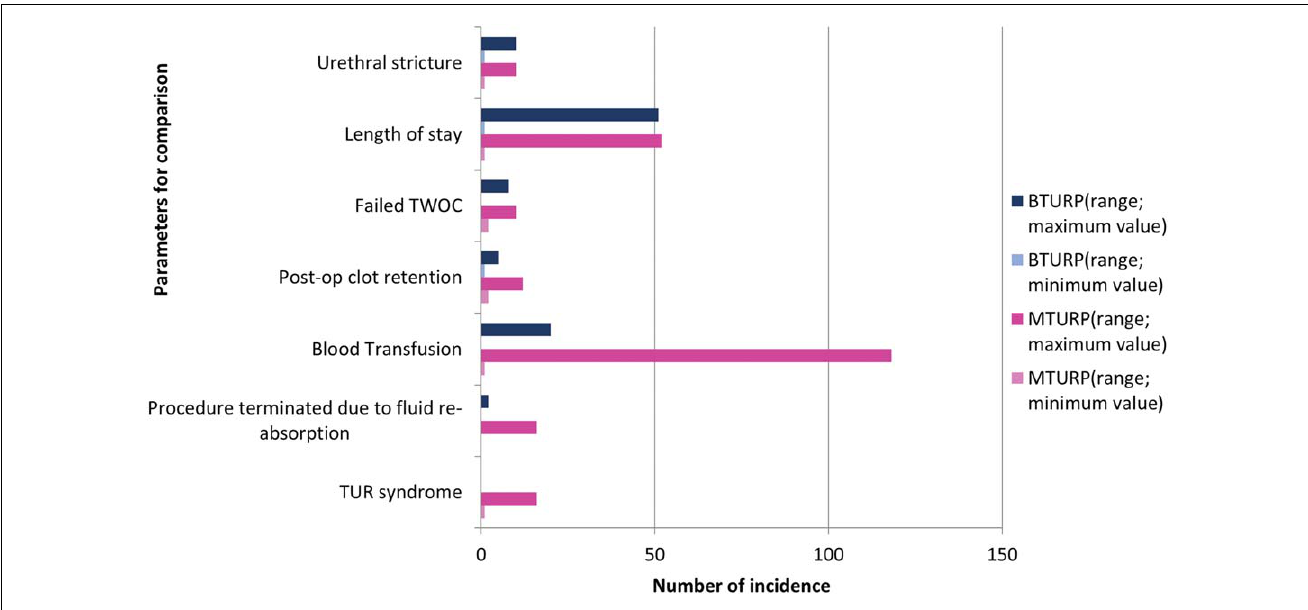
Figure 2. Comparison between number of incidence between different parameters as found in studies included for BTURP vs